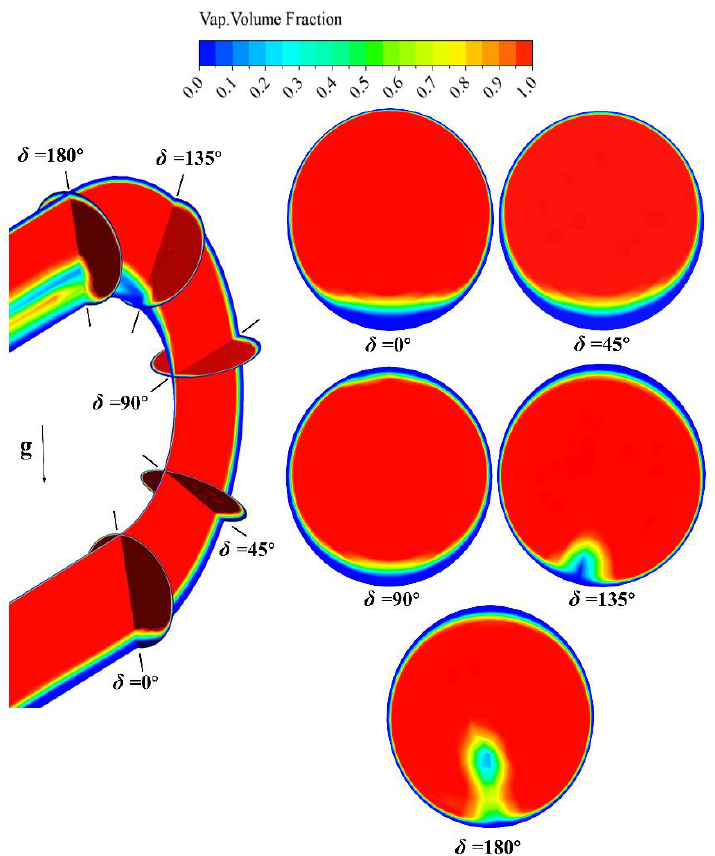
Figure 9. Distribution of volume fraction of vapor phase in the U-bend section under G = 300 Distribution of volume fraction of vapor phase in the U-bend section under kg/(m 2 ·s) in VUB tube. G = 300 kg/(m 2 · s) in VUB